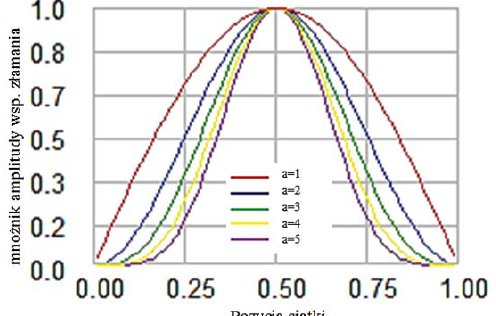
Fig. 10. Cosine apodization function for different values of the parameter А.